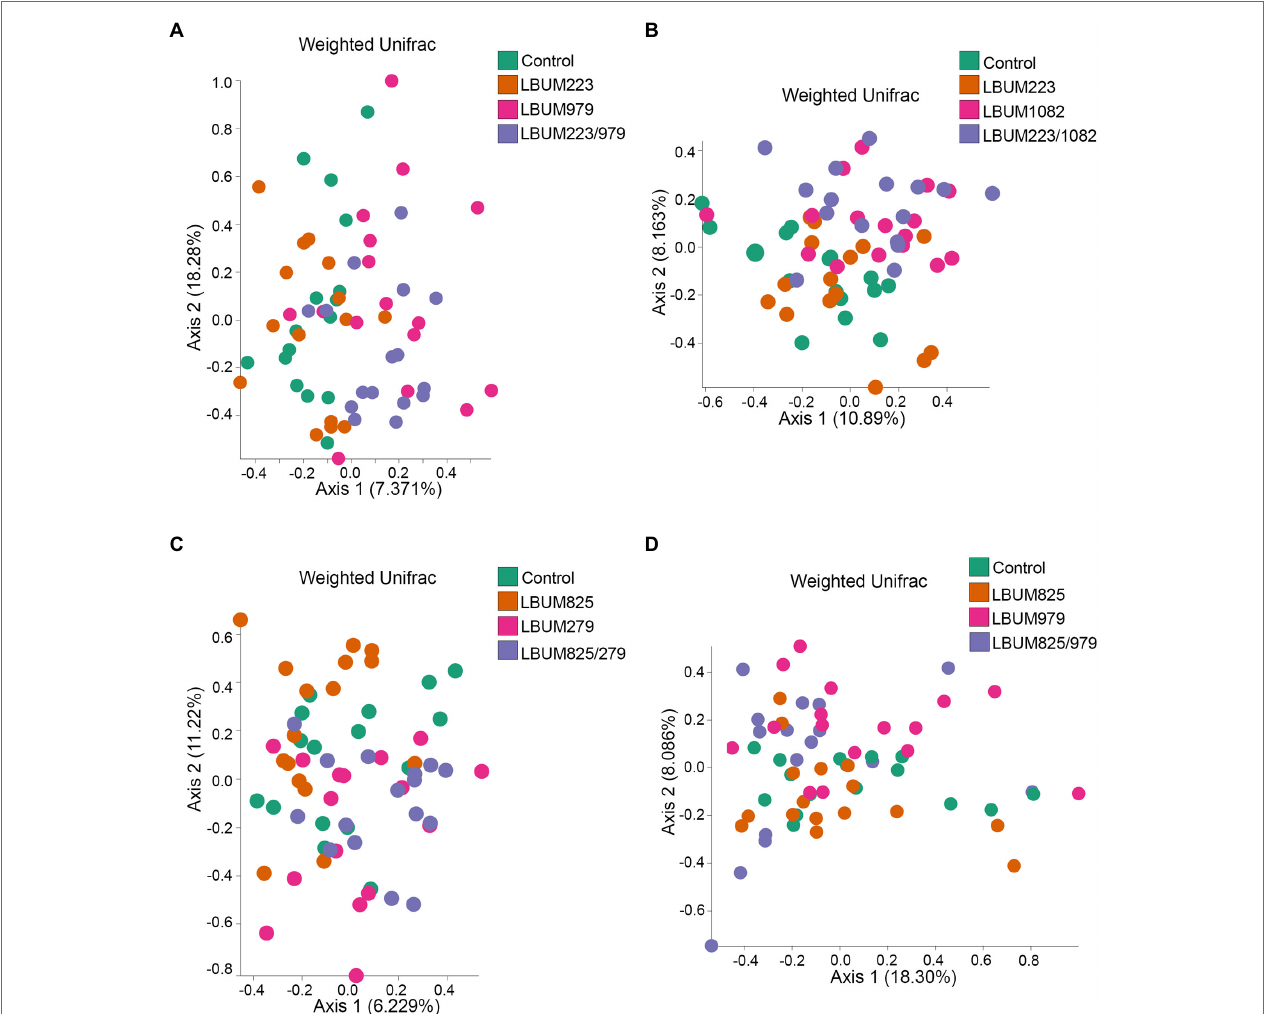
FIGURE 4 | Weighted UniFrac beta-diversity metric between treatment conditions in Canna coco rhizosphere. PCoA plot representative of beta-diversity between the treatment groups; (A) LBUM223 and LBUM979, (B) LBUM223 and LBUM1082, (C) LBUM825 and LBUM279 (D) LBUM825 and LBUM979, alone or in combination (the control refers to plants inoculated with water). Pseudomonas spp. treatments are represented by orange circles, Bacillus spp. by pink circles, combinatorial treatments by purple circles and the control by green. Each point represents a sample and axis 1 and axis 2 represent the percentage of variance explained by each coordinate. Statistical analysis is described in the text (ANOSIM and